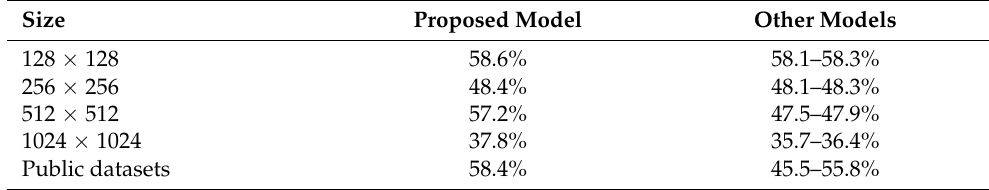
Table 4. Expected performance—compression percentages compared with those of other models.